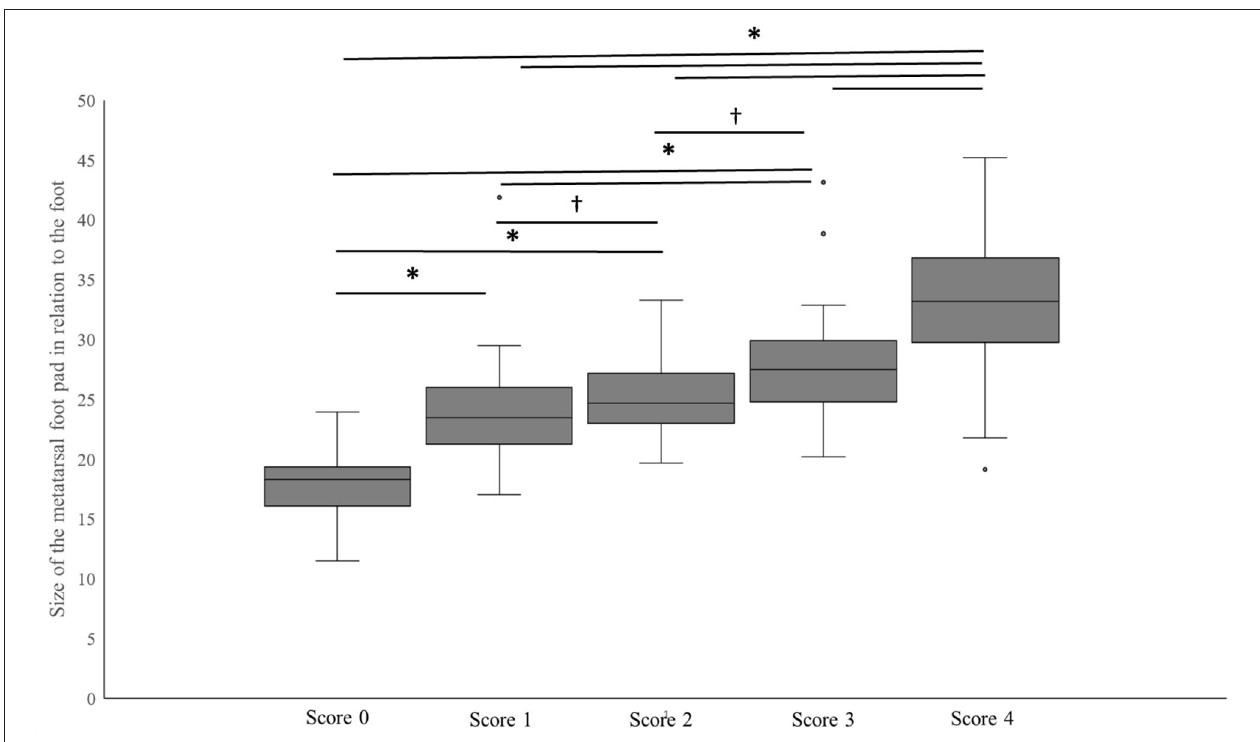
FIGURE 7 | Size of the metatarsal pad (independent of alterations) in relation to the size of the total foot for the scoring levels of the standard FPD scoring system. Data are presented as boxplots (data range, median, lower quartile, and upper quartile), *indicates a p < 0.05, † indicates a p < 0.1, n = 242